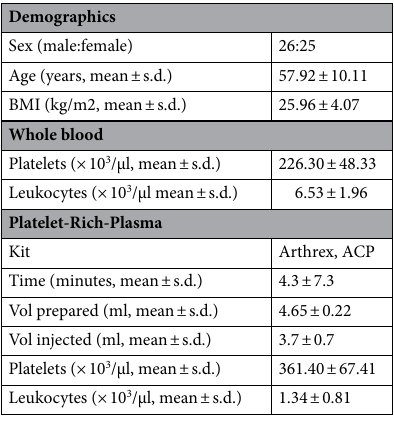
Table 1. Patient demographics and platelet-rich-plasma